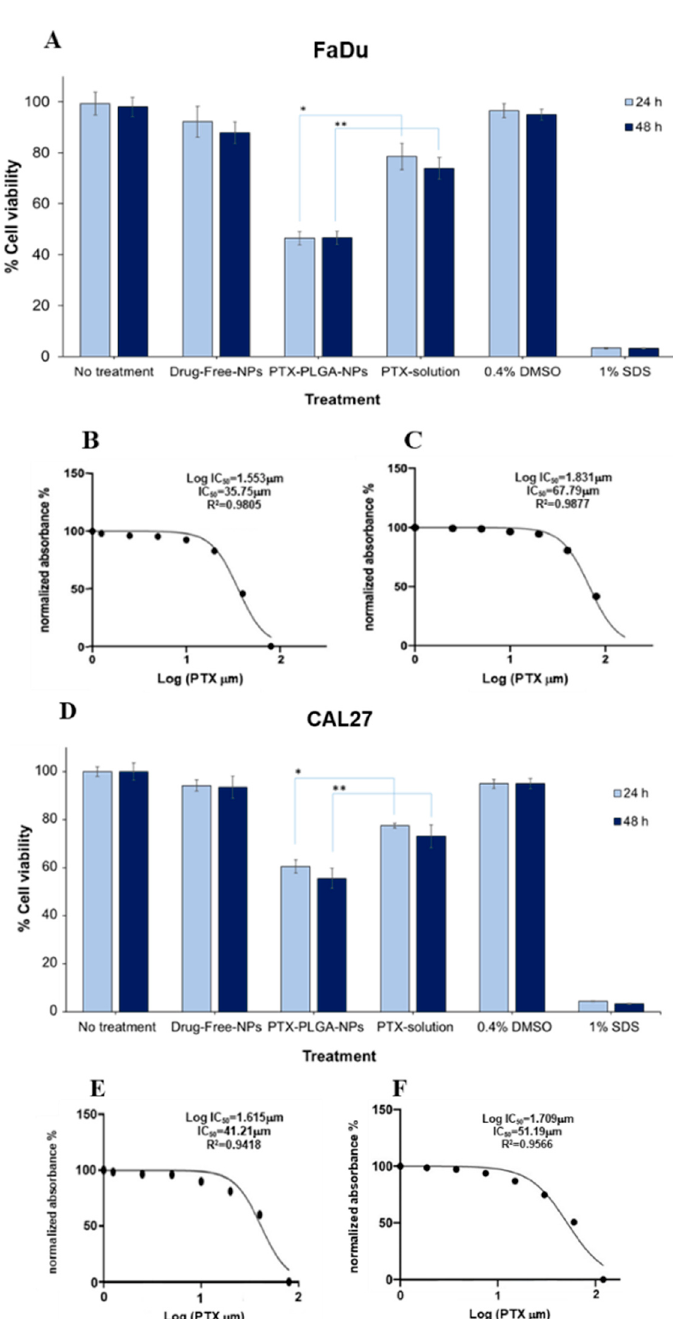
Figure 9. Determination of % cell viability ( A ) In vitro cytotoxicity results using FaDu cells treated for 24 h and 48 h; ( B ) Determination of IC 50 for optimized PTX-PLGA-NPs and ( C ) free PTX solution using FaDu cells; ( D ) In vitro cytotoxicity results using CAL27 cells treated for 24 h and 48 h; ( E ) Determination of IC 50 for optimized PTX-PLGA-NPs and ( F ) free PTX solution using CAL27 cells. * p < 0.05, ** p < 0.01.